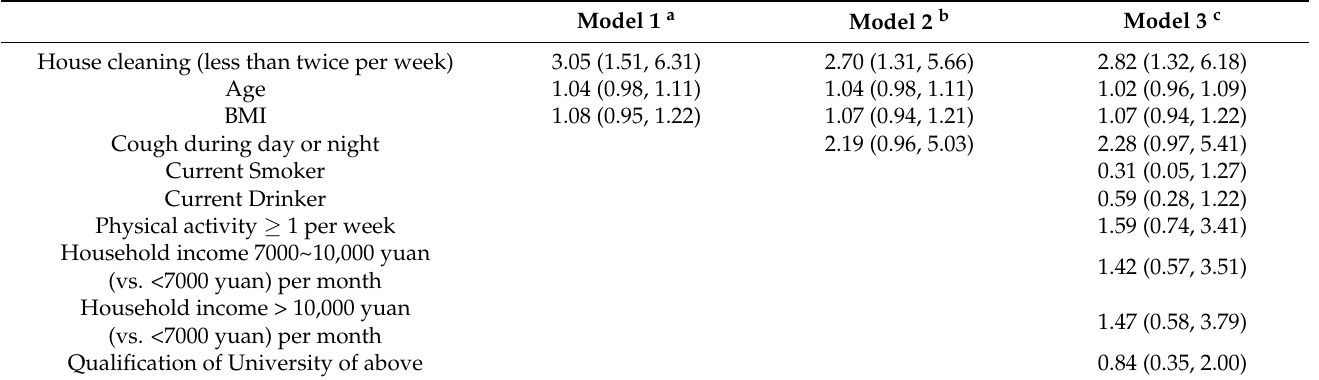
Table 2. Association between house cleaning frequency and miscarriage adjusting for common